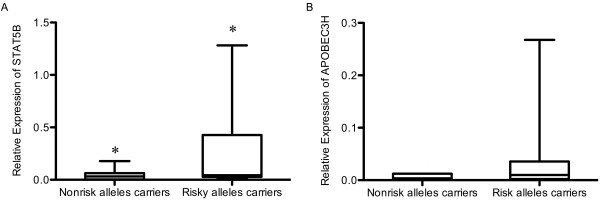
The correlation between risk alleles and nearby gene expression. (A) STAT5B mRNA expression grouped by risk alleles carriers and nonrisk alleles carriers. The individuals who carry at least 3 risk alleles out of the 5 SNPs on chromosome 17 are enrolled in risk alleles carriers group. The rest are enrolled in nonrisk alleles carriers group. (B) APOBEC3H mRNA expression grouped by risk alleles carriers and nonrisk alleles carriers. The individuals who carry 4 risk alleles of all those 4 SNPs on chromosome 22 are enrolled in risk alleles carriers grope. The rest are enrolled in nonrisk alleles carriers group includes the rest. (*P = 0.011 and P = 0.080 for Figure 2B).